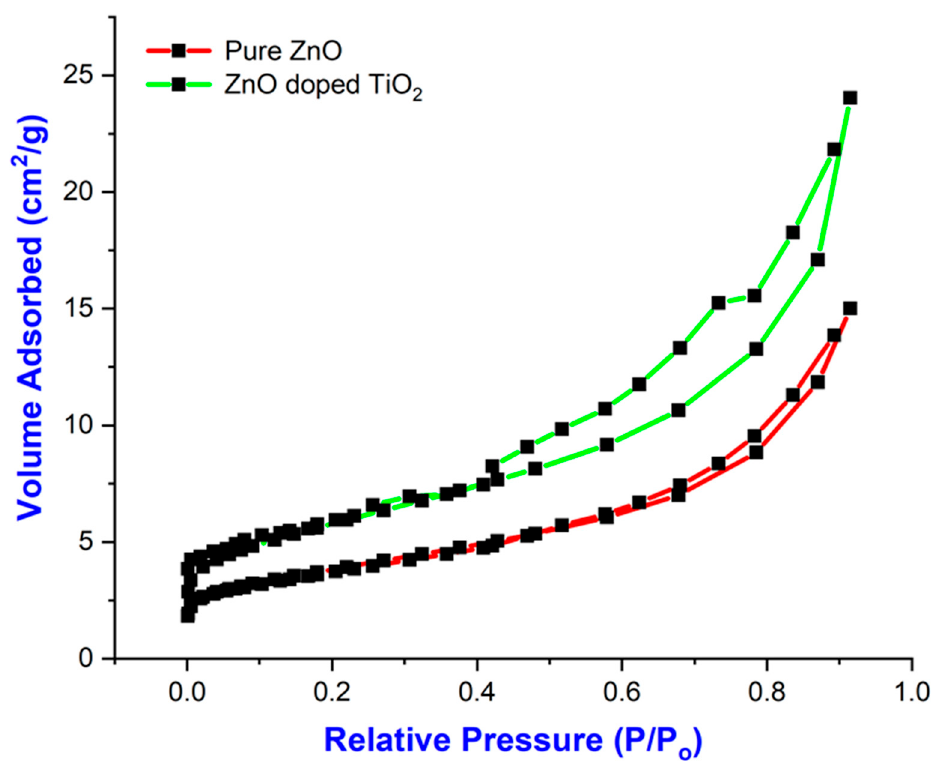
Figure 11. The surface area of pure ZnO and ZnO-doped TiO 2 nanocomposites and their relative pressures vs. the adsorbed volumes according to BET coefficients.